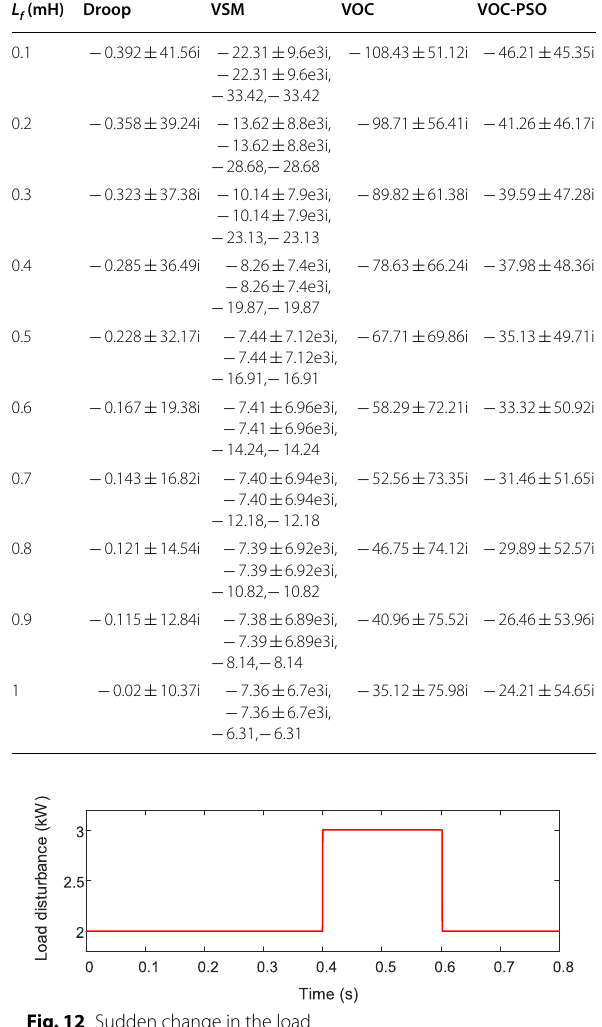
Table 3 Eigenvalues for different filter inductor values L f (mH) Droop